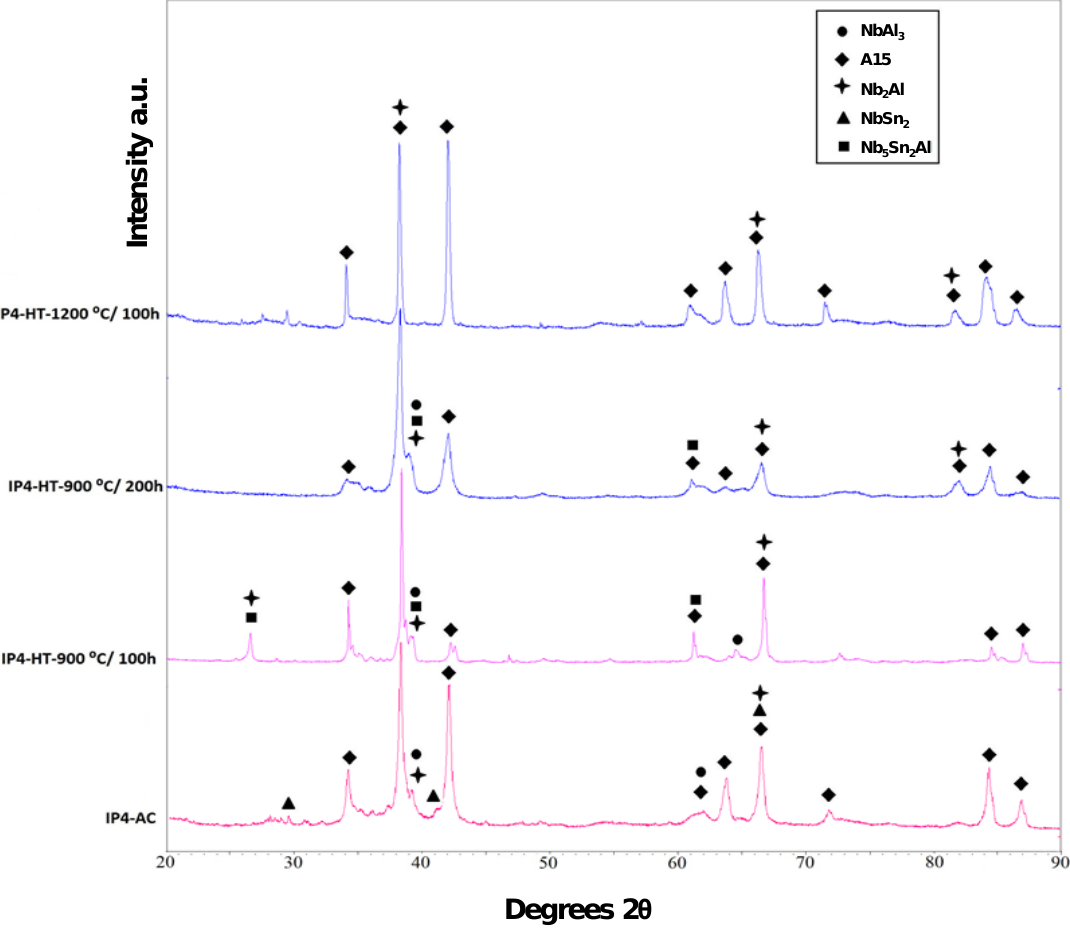
Figure 1. XRD patterns of IP4-AC, IP4-HT-900 °C/100h, IP4-HT-900 °C/200 h and IP4-HT-1200 °C/100 h.